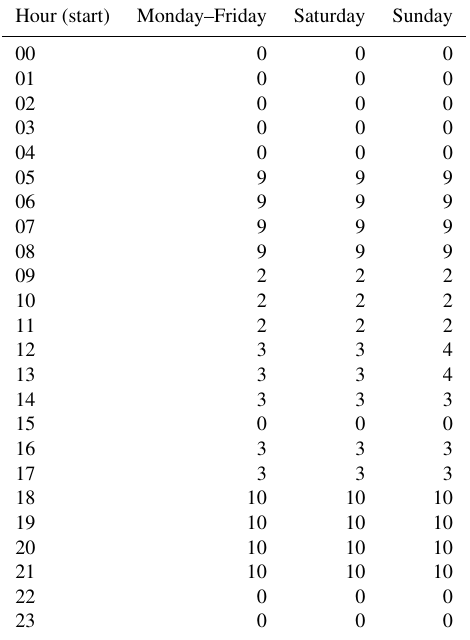
Table A7. Share of total daily combustion used in emission inven- tory for wood boilers separated in weekdays and Saturday and Sun-